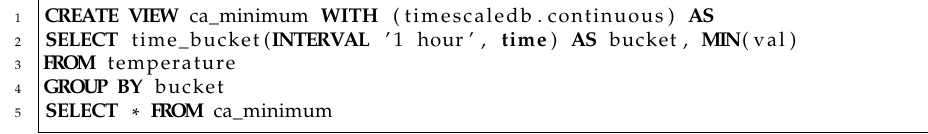
Figure 11. Continuous aggregate in